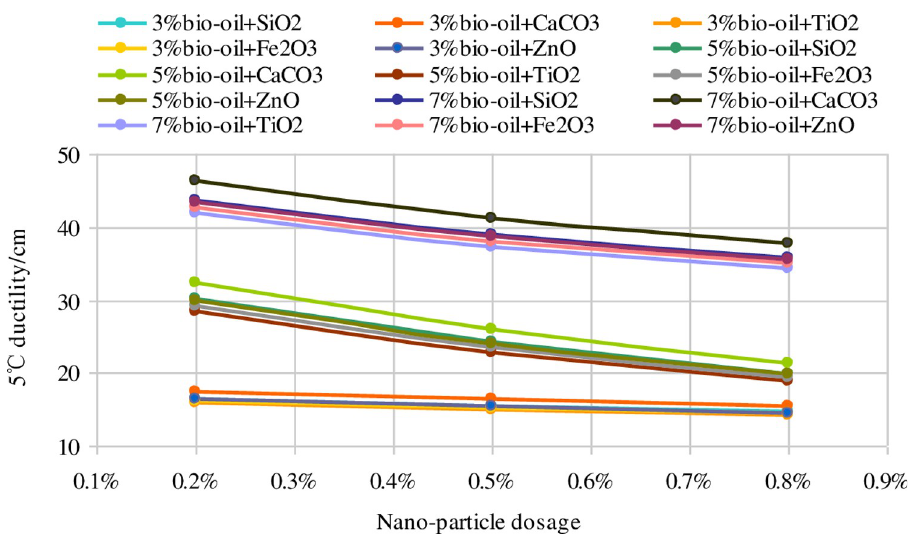
Fig 3. Trend of 5˚C ductility with different nano-particle